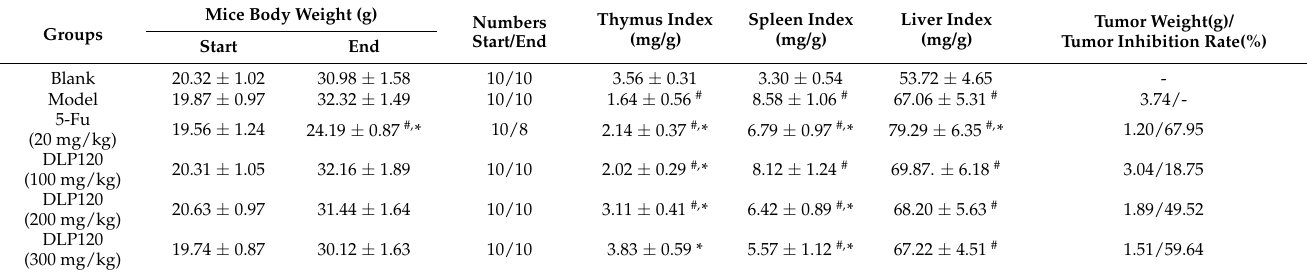
Table 1. Effects of DLP120 on organs indexes of H22 tumor-bearing